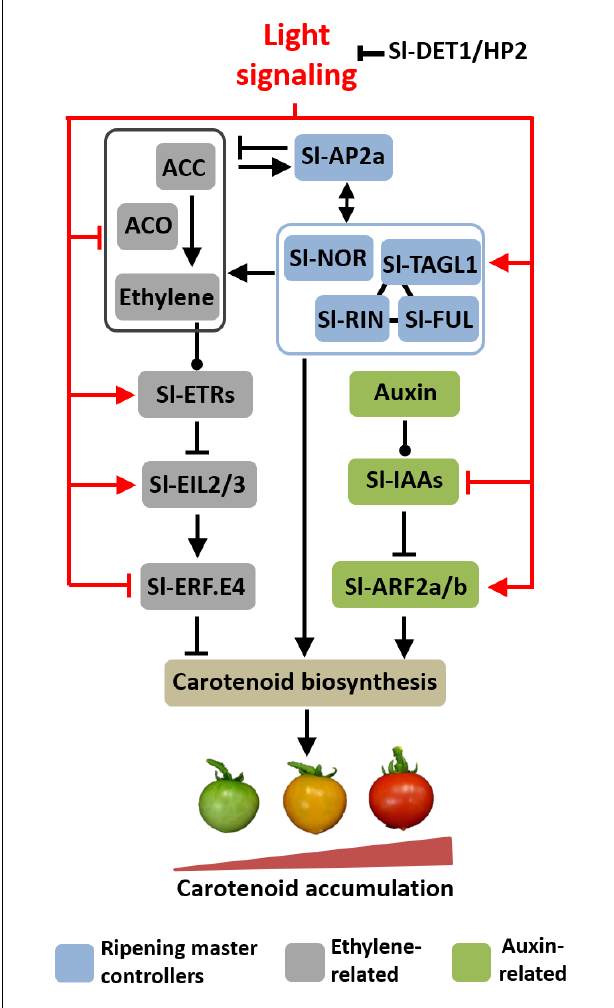
FIGURE 6 | Proposed model for light-hormonal interaction controlling tomato fruit carotenoid biosynthesis. Light signaling promotes master regulators of ripening, which positively regulate carotenoid biosynthetic genes. Light also down-regulates ethylene metabolism and emission and reduces the expression of ETHYLENE RESPONSE FACTOR E4 ( Sl-ERF.E4 ), a key repressor of tomato fruit carotenogenesis. Moreover, light represses AUXIN/INDOLE-3-ACETIC ACID ( Sl-IAAs ) genes and up-regulates both AUXIN RESPONSE FACTOR 2 paralogues ( SlARF2a/b ), consequently promoting most components of the tomato carotenoid biosynthetic route. Additionally, light signaling up-regulates genes encoding ethylene receptor (ETRs) and intermediate components in ethylene signaling cascade (EILs). The arrow- and bar-headed lines indicate stimulatory and inhibitory effects, respectively. The lines terminated by a circle describe more complex interactions. RIN, ripening inhibitor; NOR, non-ripening; FUL, fruitfull; AP2a, apetala2a, TAGL1, tomato agamous-like1; ETR, ethylene response; EIL, ethylene insensitive